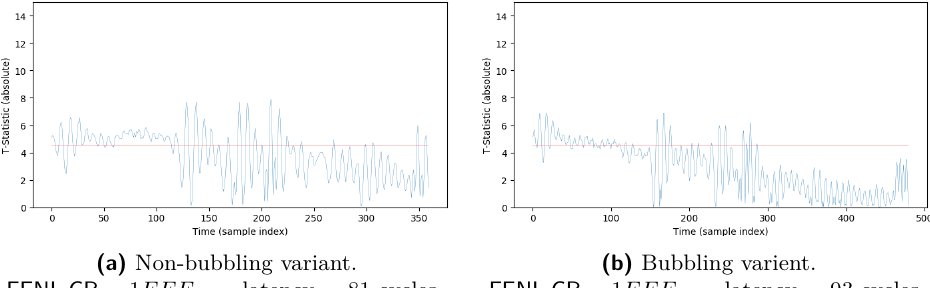
Figure 12: Results for experiment 5, relating to leakage from Figure 6 as executed on the SCARV core (randomisation-based flush semantics). Note that the t-statistic is plotted in absolute form; the plots are cropped wrt. the target kernel, which has a longer latency post -insertion of fence